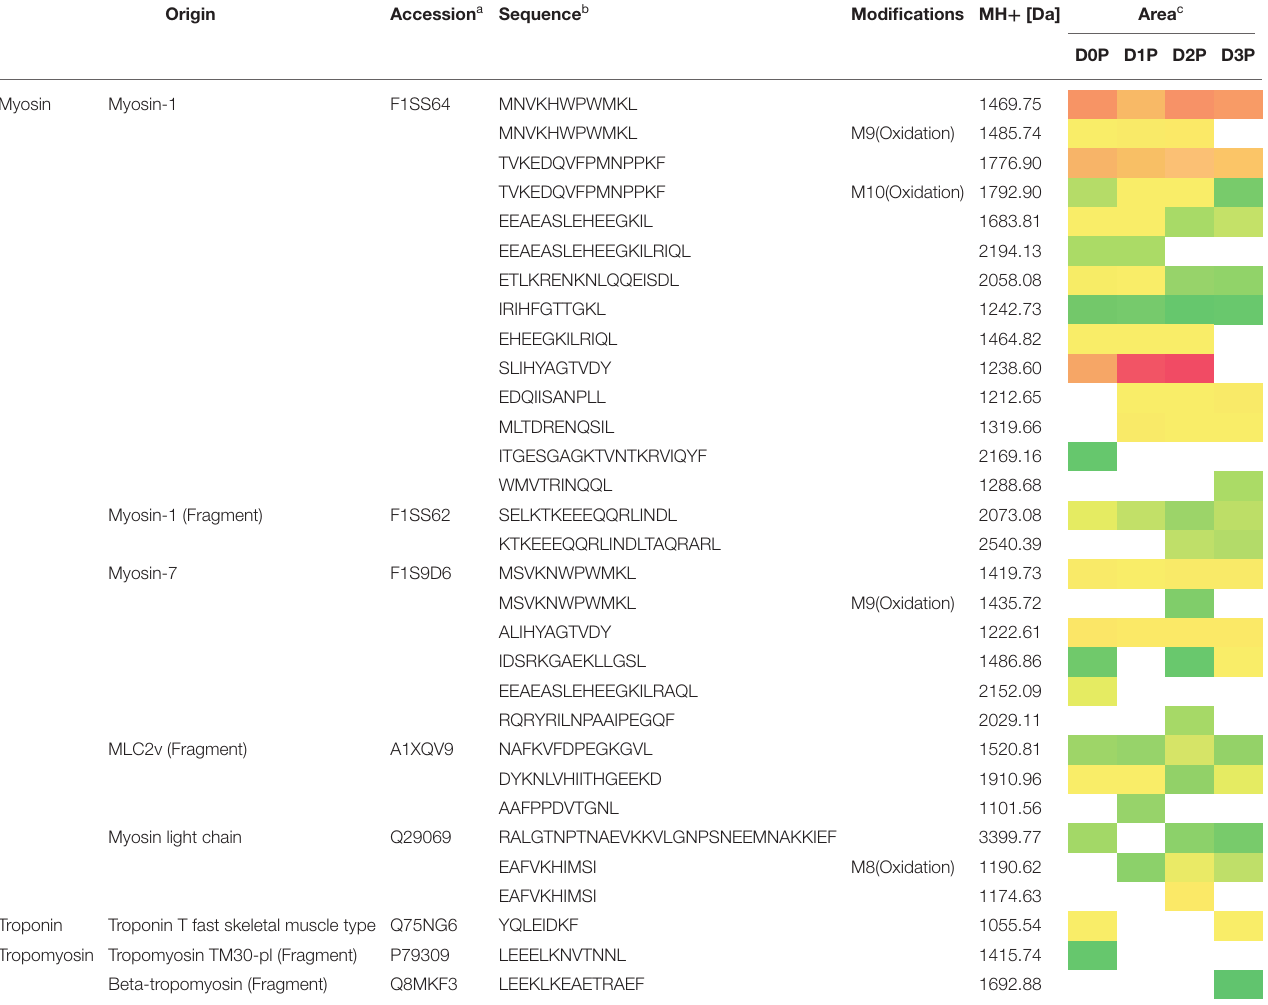
TABLE 1 | Dynamic evolution of peptides derived from myofibrillar proteins after gastric